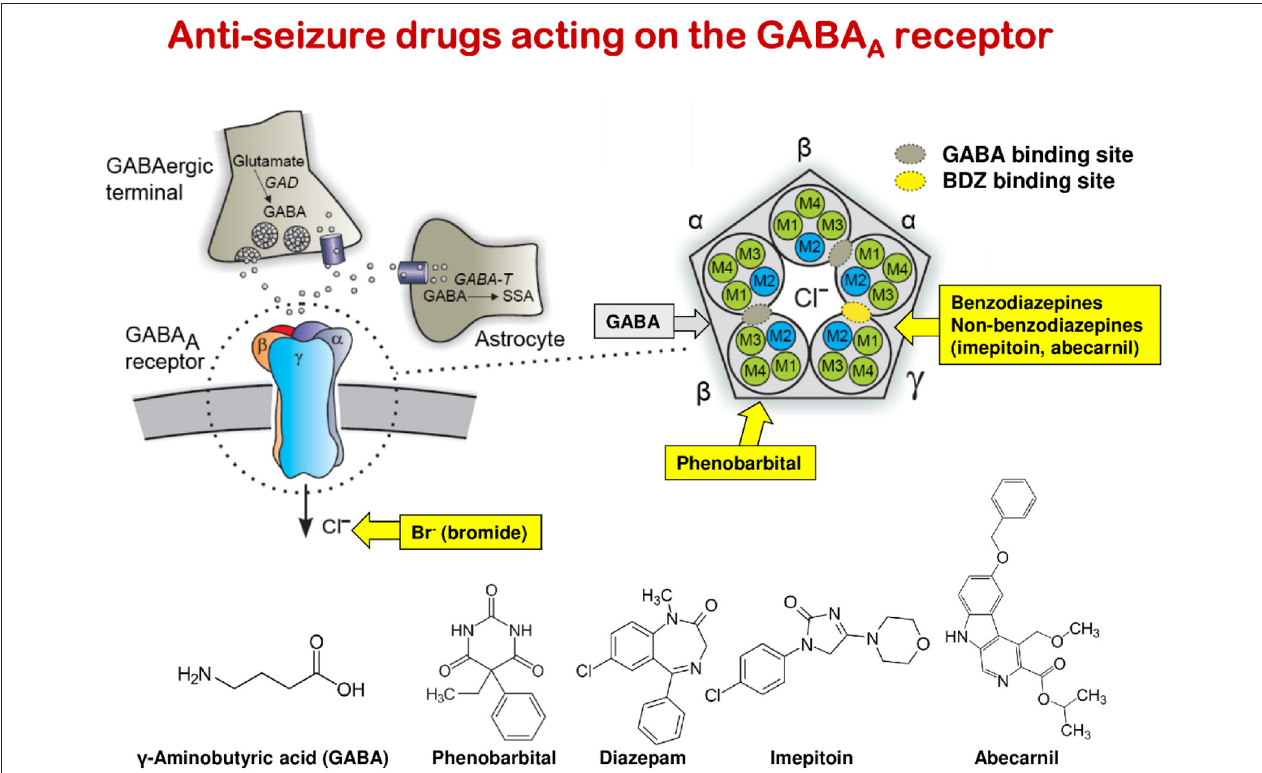
FIGURE 6 | Simplified schemes of the inhibitory GABAergic synapse and the structure of the GABA A receptor illustrating the site of action of benzodiazepines (BZDs) and other drugs acting via this site. The left part of the figure illustrates a GABAergic synapse showing synthesis, vesicular packaging, release, uptake, and degradation of GABA in GABAergic nerve terminals; uptake into astrocytes; and the pentameric subunit structure of a typical GABA A receptor complex in the postsynaptic membrane, consisting of α -, β , and γ -subunits. Components of the GABAergic synapse shown include glutamic acid decarboxylase (GAD), the enzyme that catalyzes the decarboxylation of glutamate to GABA; GABA-containing synaptic vesicles (circles containing GABA molecules); the GAT-1 GABA transporter (cylinders); and conversion of GABA to succinic semialdehyde (SSA) by GABA transaminase (GABA-T). The right part of the figure illustrates schematically the pentameric structure of the GABA A receptor within the plane of the neuronal membrane showing the relative positions of the transmembrane domains. Subunit interfaces are formed by M3 and M1. The interfacial locations of the two GABA and one BZD recognitions sites are shown. By binding to the BZD site, BZDs (e.g., diazepam, midazolam, and others), β -carbolines (e.g., abecarnil), and imidazolone derivatives (e.g., imepitoin) act as positive allosteric modulators of GABA leading to increased chloride channel opening frequency, increased chloride influx, and, consequently, to increased hyperpolarization of the membrane and thus inhibition of the postsynaptic neuron. Barbiturates such as phenobarbital also bind to the GABA A receptor to potentiate GABA, but the exact binding site is less well-established. Bromide ions (as produced by administration of potassium bromide) enhance GABAergic inhibition but the mechanism is distinct from that of BDZs and barbiturates in that Br- ions compete with Cl − ions for GABA-gated Cl − channels and, at high concentrations, enter the neuron through these channels, thereby inducing a lasting hyperpolarization of the neuronal membrane. Once Br − ions have entered a neuron, they can only very slowly be eliminated from the neuron, explaining the poor therapeutic ratio and risk of intoxication with potassium bromide. The figure was modified from Rundfeldt and Löscher ( 101). For comparison, also the chemical structures of GABA, phenobarbital, a BDZ (diazepam), imepitoin, and abecarnil are